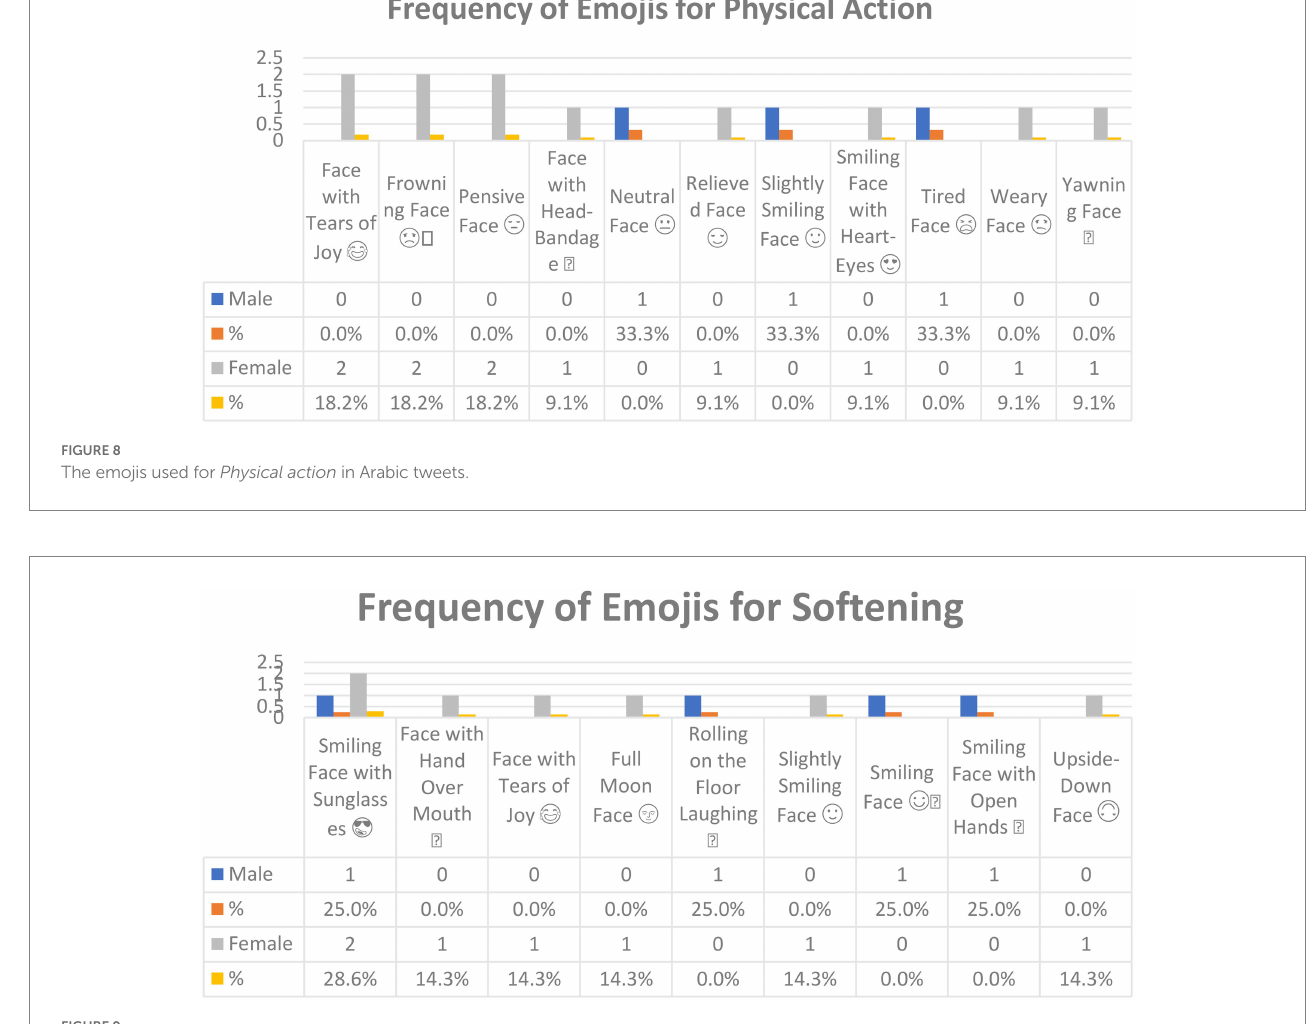
FIGURE 9 The emojis used for Softening in Arabic tweets.